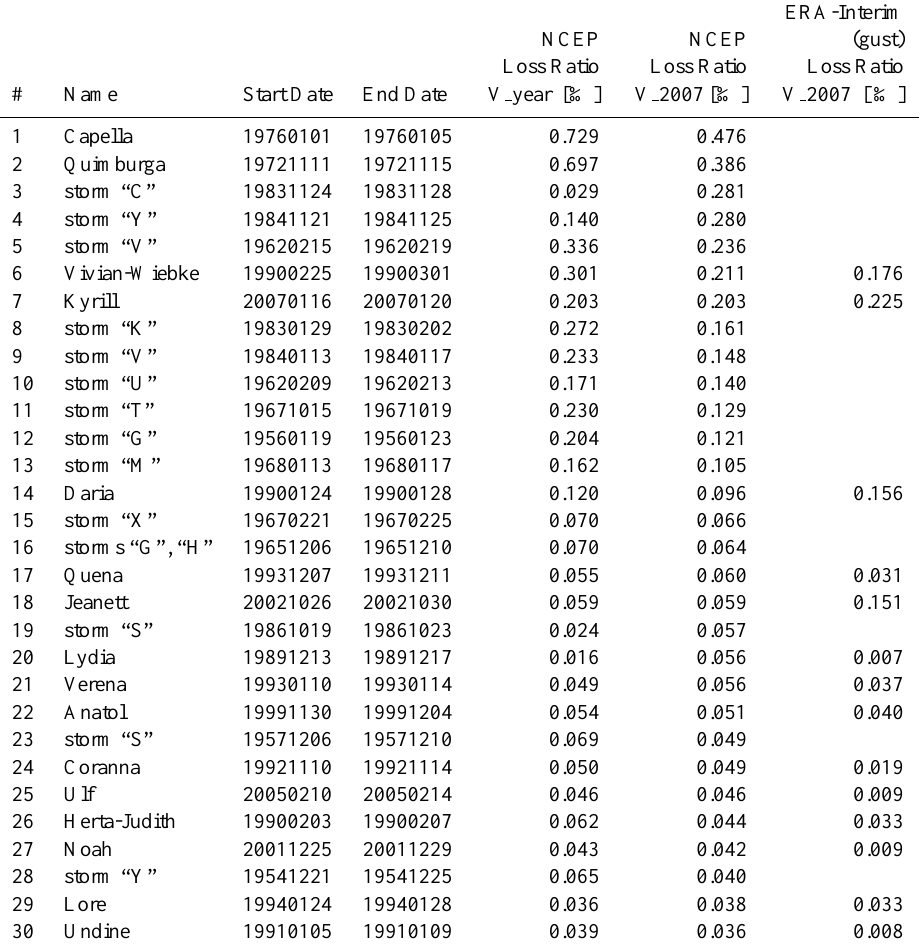
Table 3. Same as Table 2, but for storm events identified by applying the loss model to NCEP reanalysis (1948–2009). For those storms occurring since 1989, the respective loss calculated based on ERA-Interim (gust) is also shown. Loss ratios were calculated using the distribution of values for the specific year (column “Loss Ratio V year”, see explanations in the text) and the most recent value distribution (i.e., 2007, column “Loss Ratio V